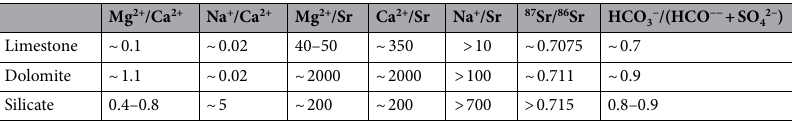
Table 5. Molar ratios of the river end-members.